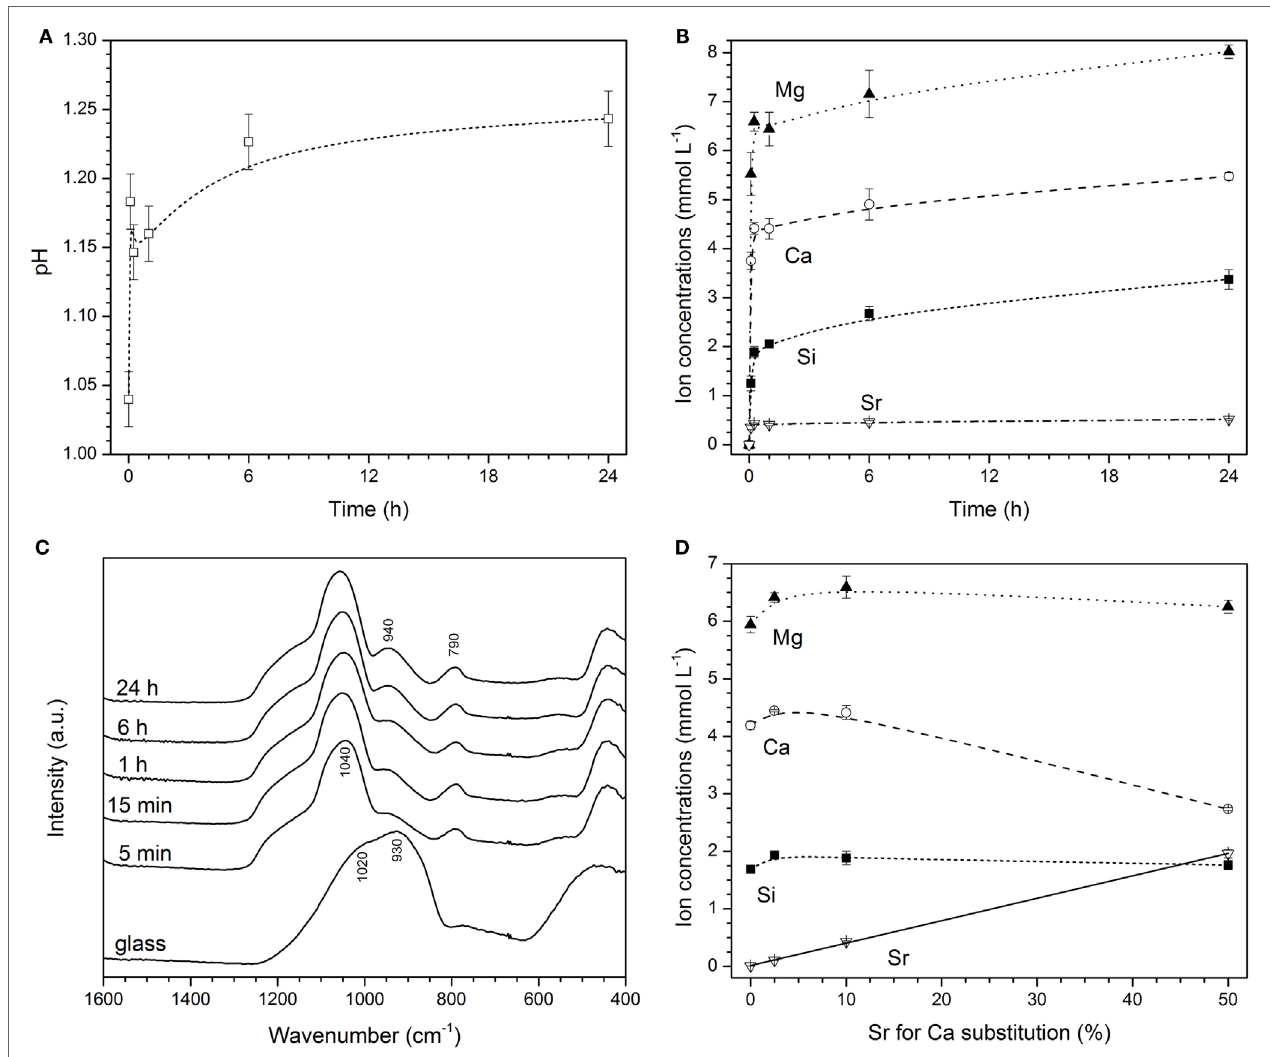
FigUre 2 | changes in (a) ph, (B) concentrations of ions in hcl/Kcl buffer, and (c) FTir spectra with immersion time of glass sr10 . (D) Changes in concentrations of ions with strontium for calcium substitution in the glass for glasses immersed in HCl/KCl buffer for 15 min (solid line: linear regression; R 2 =